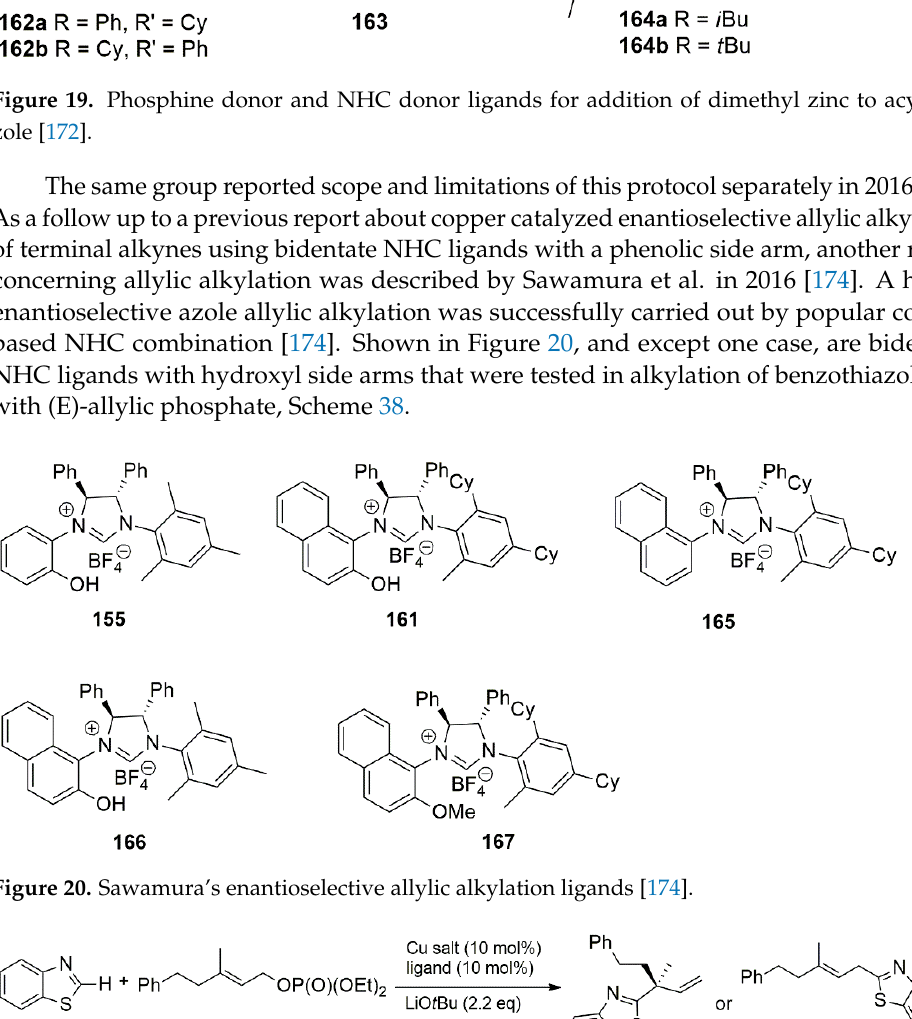
Figure 19. Phosphine donor and NHC donor ligands for addition of dimethyl zinc to acylimiazole [172].